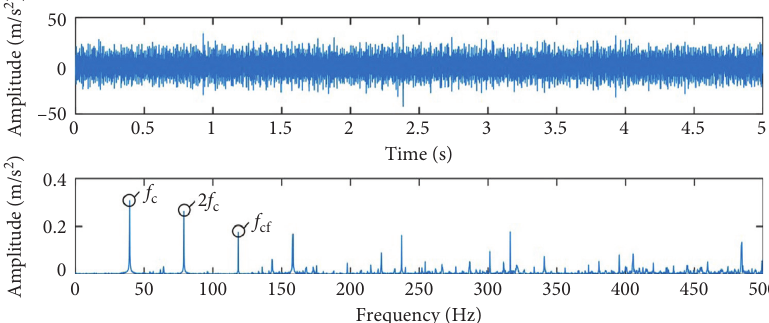
Figure 8: Original vibration